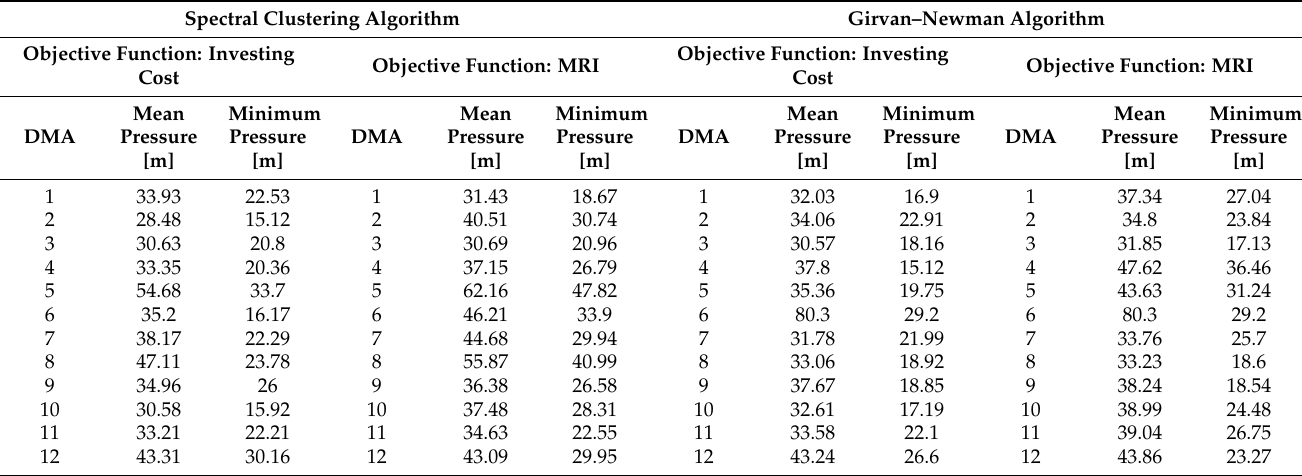
Table 4. DMAs minimum and mean pressure after different WDNP.